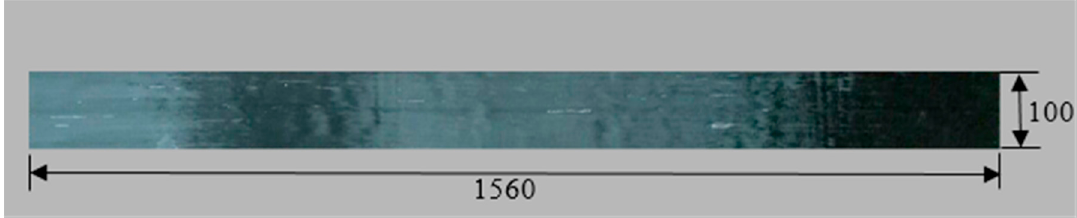
Figure 4. Size and reinforcements (steel bars) in the reinforce concrete (RC) beam (unit: mm).